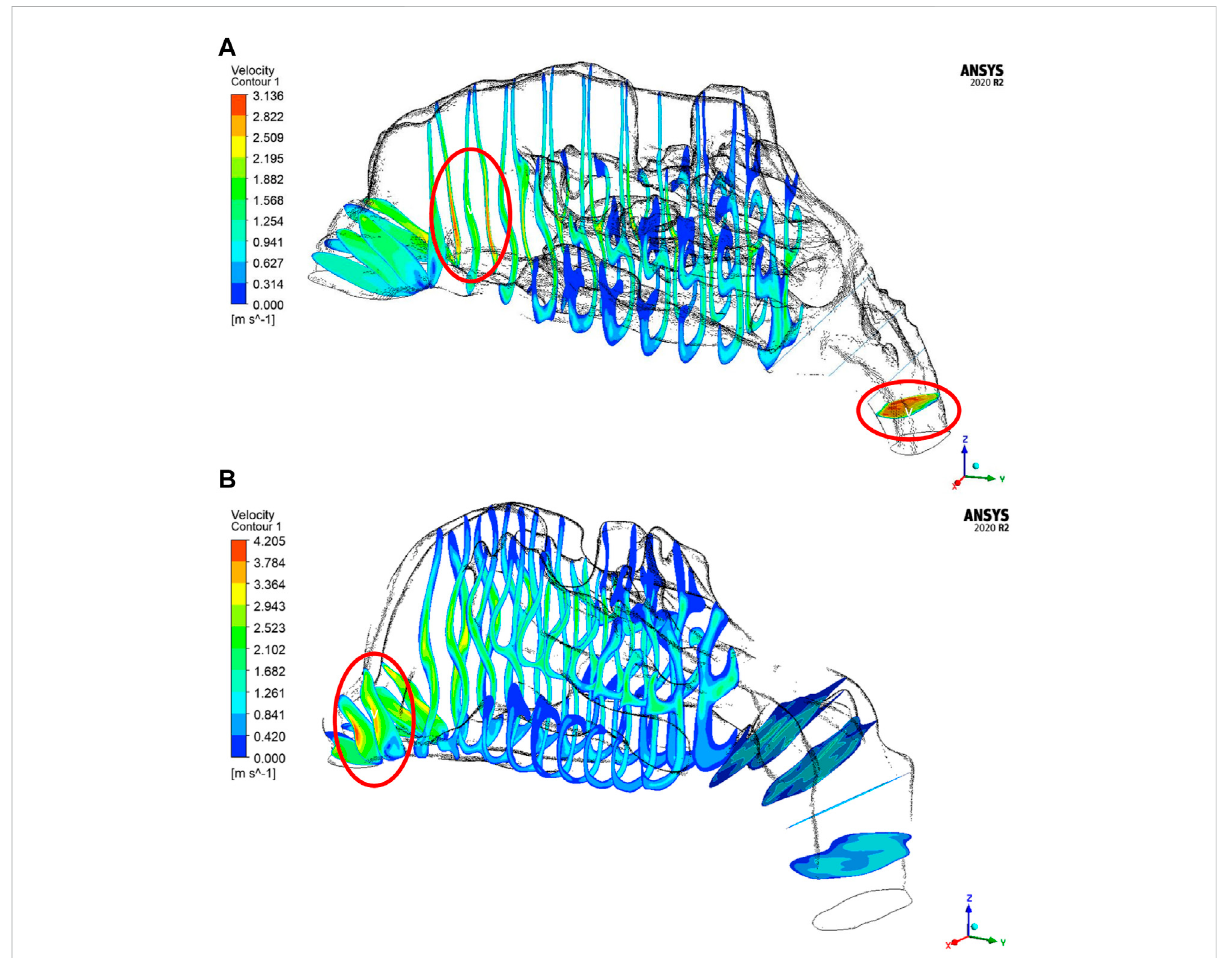
FIGURE 7 Velocity contours in (A) P01-Septal deviated nasal cavity (B) P02- Healthy nasal